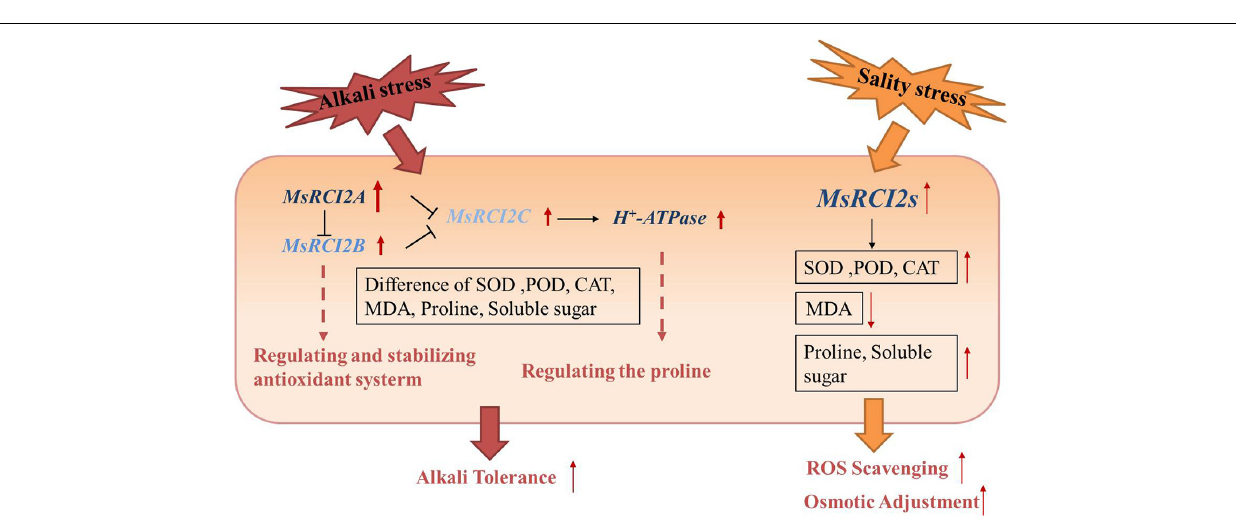
FIGURE 6 | Functional model of the MsRCI2 response to alkali and salinity stress. The main functions of MsRCI2s are as follows: (1) ROS scavenging and osmotic adjustment in response to salinity stress; (2) differences in MsRCI2 gene expression and regulatory relationships with H + -ATPase or MsRCI2 s; and (3) overexpression of MsRCI2A/B / C genes enhanced alkali and salt